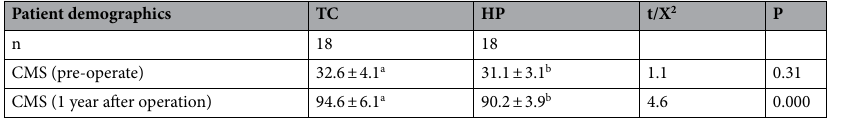
Table 4. Comparison of constant-Murley score (CMS). a Compared with CMS (pre-operate) and CMS (1 year after operate) of TC group, t = − 49.8, P = 0.000. b Compared with CMS (pre-operate) and CMS (1 year after operate) of HP group, t = − 65.3, P =